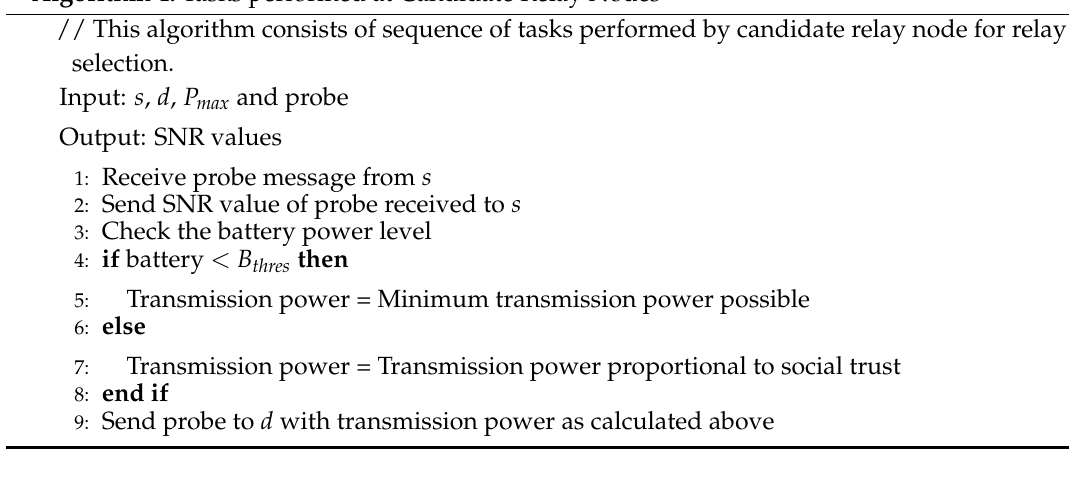
Algorithm 4: Tasks performed at Candidate Relay Nodes // This algorithm consists of sequence of tasks performed by candidate relay node for relay selection.